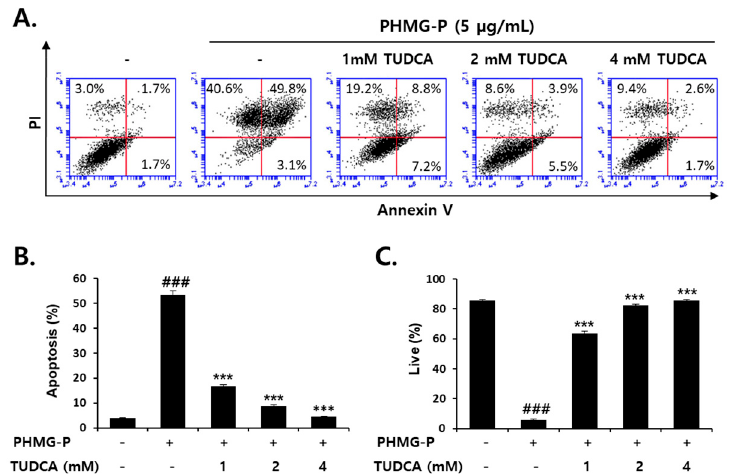
Figure 7. The inhibition of PHMG-P-induced apoptotic cell death by the ER stress inhibitor, TUDCA. ( A ) The cells were pretreated with TUDCA and then treated with 5 µg/mL PHMG-P for 24 h. The FACS analysis of propidium iodide uptake and annexin V binding in non-permeabilized cells (lower left, live cells; lower right, early apoptotic cells; upper right, late apoptotic cells; upper left, necrotic